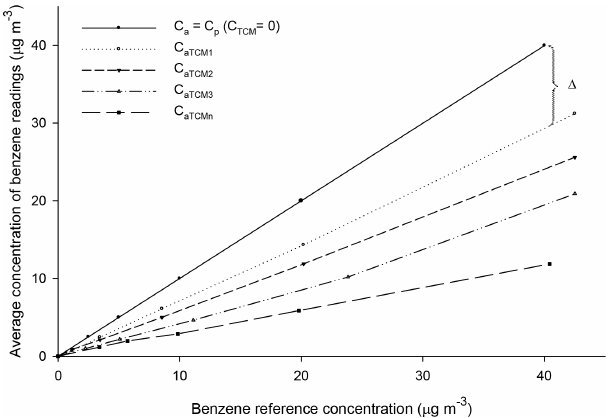
Figure 3. A generic representation of benzene readings as a func- tion of the concentration of benzene and TCM in the reference gas